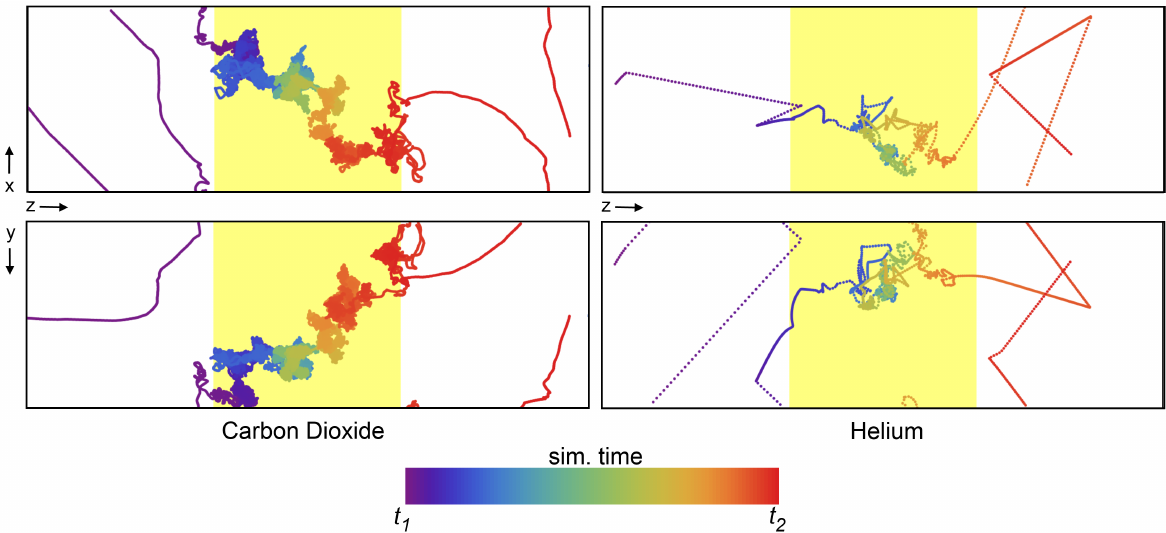
Figure 7. The movement of a single CO molecule (left) and He atom (right) through the 2 polymer matrix (yellow shaded region). Each point represents the location of a molecule at every 0.5 ps of simulation time, with the color of the points scaled according to the relative time (see color bar). The simulation time was selected such that only a single permeation event of the many occurring during the 10-ns simulation is shown. ∆ t = t is 3.4 ns for CO and 80 ps for Helium. The top and bottom plots represent the XZ and YZ 2 projections,